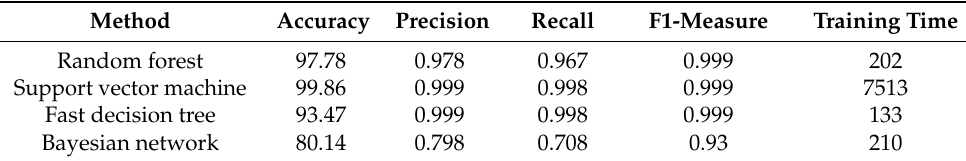
Table 4. Experimental results using the ResNet18 features with different